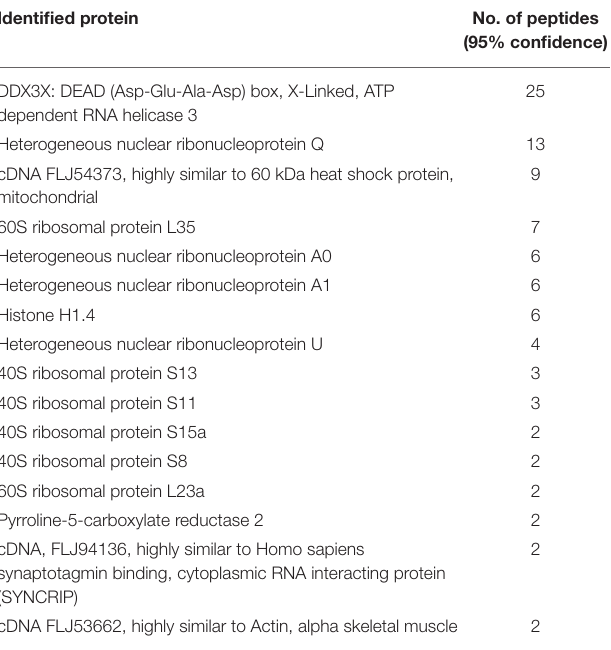
TABLE 1 | List of identified potential capsid interacting proteins from mass spectrometry analysis. Identified protein No. of peptides